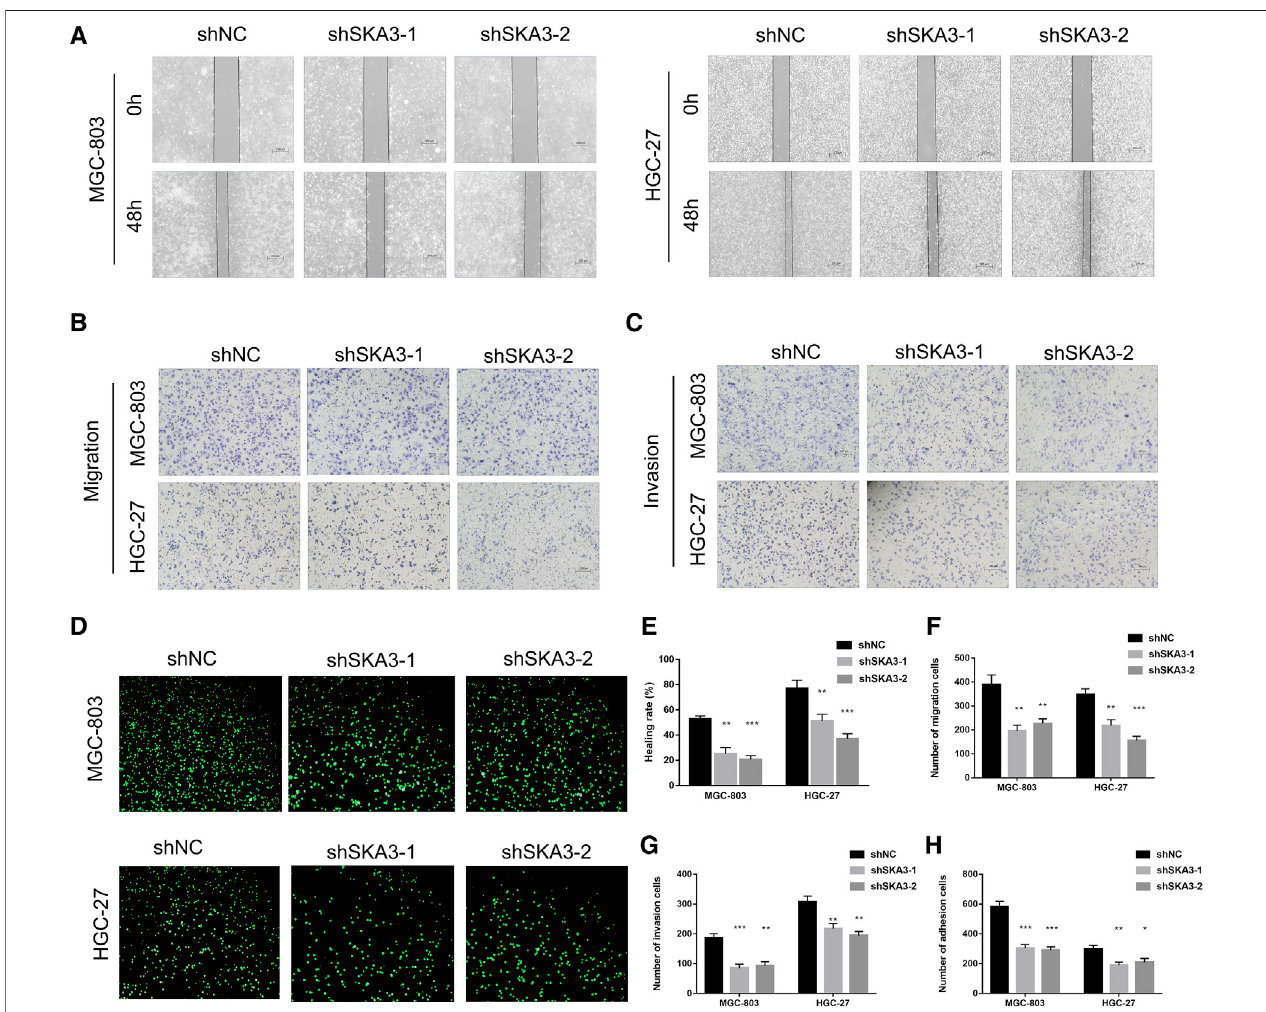
FIGURE 3 | SKA3 promotes migration, invasion and adhesion in gastric cancer. (A) Wound-healing experiments detects cell migration by silenced for SKA3 in MGC-803 and HGC-27. (B) Transwell experiment detects cell migration by silenced for SKA3 in MGC-803 and HGC-27. (C) Transwell experiment detects cell invasion bysilencedforSKA3inMGC-803andHGC-27. (D) AdhesionexperimentdetectscelladhesionbysilencedforSKA3inMGC-803andHGC-27. (E) Relativehealingrate in (A) werequanti fi edandshown. (F) Relativemigrationnumbersin (B) werequanti fi edandshown. (G) Relativeinvasionnumbersin (C) werequanti fi edandshown. (H) Relative adhesion numbers in (D) were quanti fi ed and shown. Dataare shown asmean ± SD fortriplicate experiments. The two-tailed Student ’ sunpaired t -test was used. ** p < 0.01, *** p <